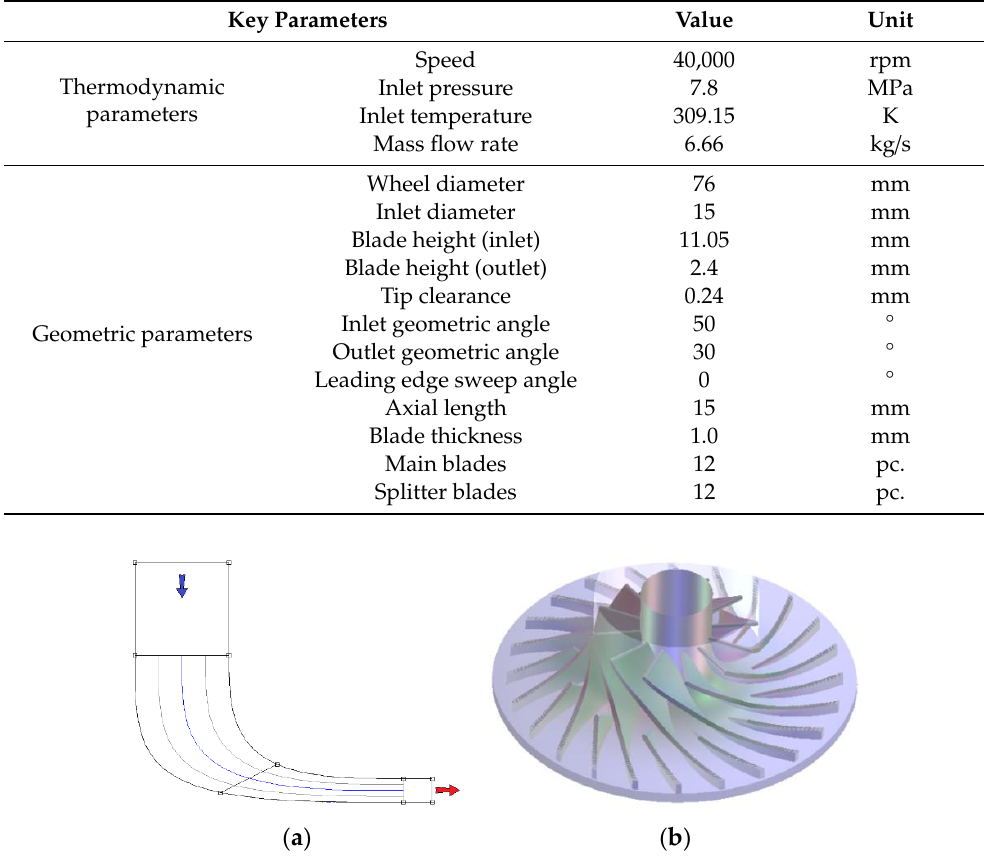
Table 2. Key parameters of the initial design of the compressor.